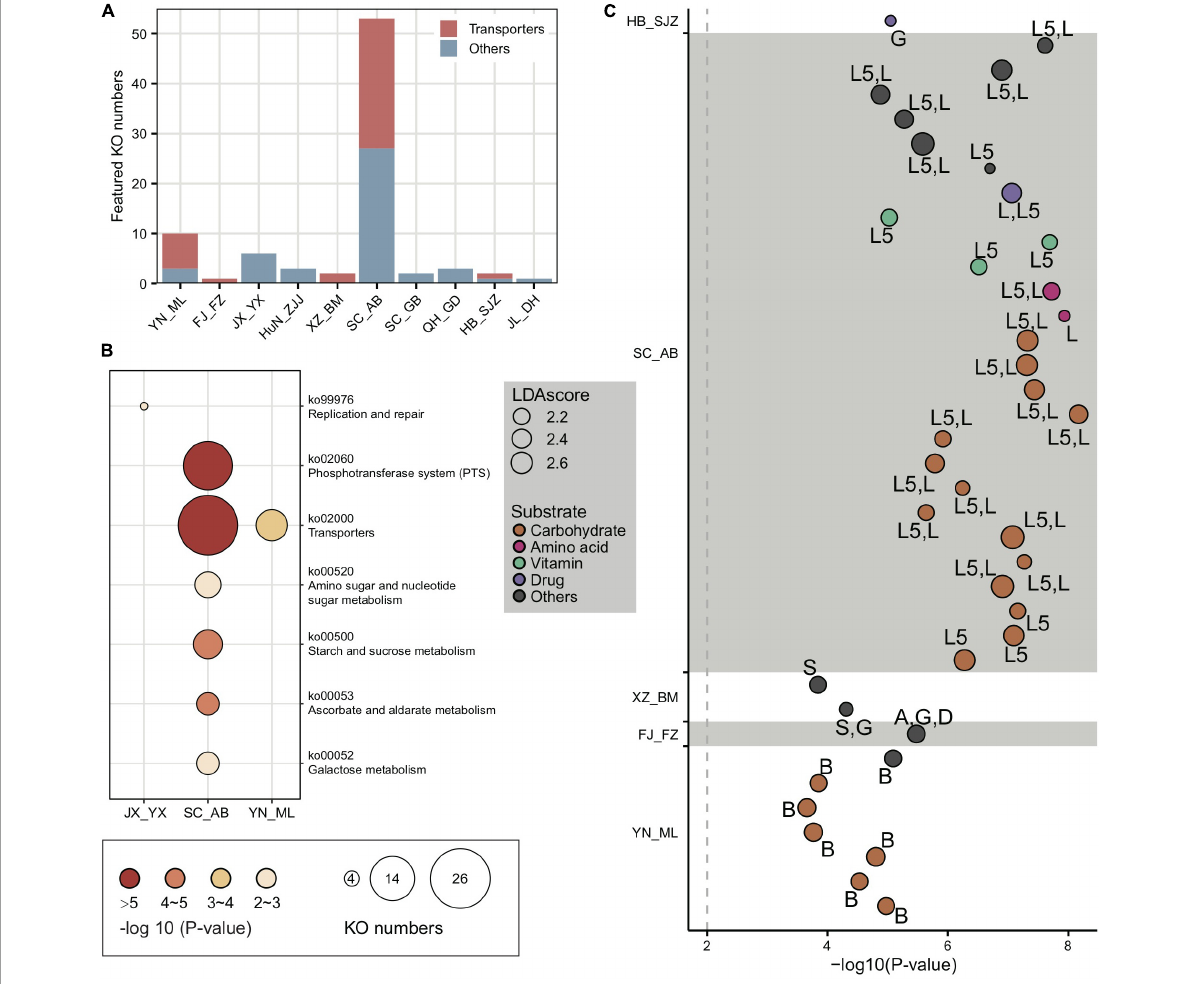
FIGURE4 Locally featured KOs were enriched in carbohydrate transporters. (A) Featured KOs in geographic populations were enriched in transporters. (B) Featured KEGG pathways in gut microbiota from A. cerana populations. The size of the bubbles represents KO numbers. (C) Transporters in featured KOs were mainly specialized for carbohydrates. The size of the bubbles represents the LDA score. The codes marked next to each bubble indicate the main contributing bacteria species, where only those with > 10% contribution were listed: A, Apibacter ; B, Bifidobacterium ; D, Dysgonomonas ; G, Gilliamella ; L, Lactobacillus that is not assigned to any known groups; L5, Lactobacillus Firm-5 ; S, Snodgrassella